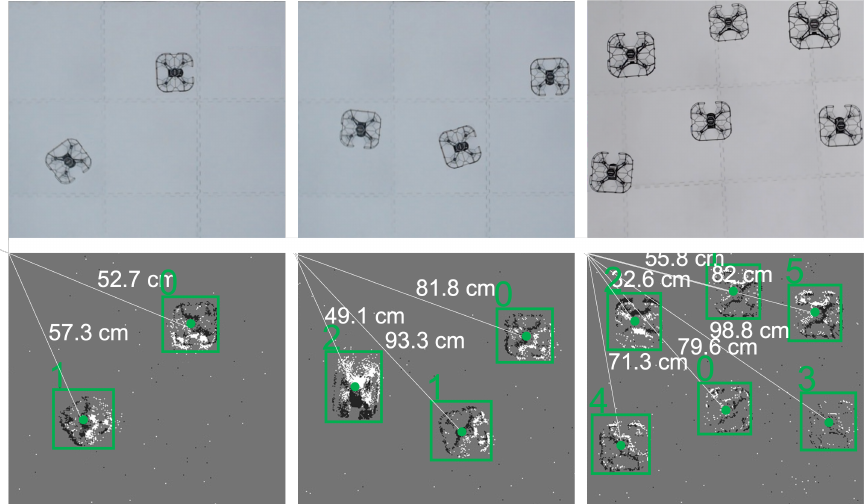
Figure 11. Indoor flight tests involving up to six quadrotors in the arena are depicted in RGB ( top ) and event ( bottom ) formats.